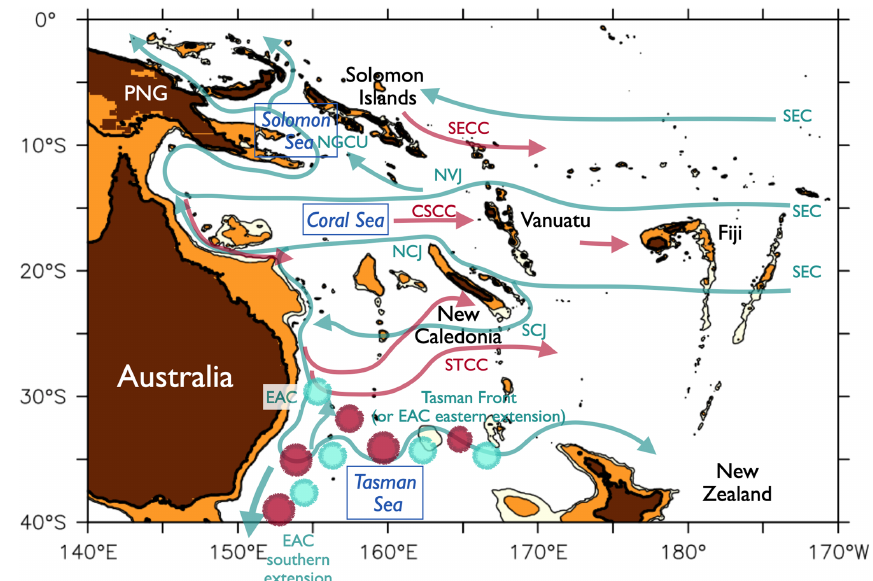
Figure 1. Reference map of the southwestern Pacific, with the names of the main islands and countries, and a schematic of the subsurface circulation (top 1000m, green arrows) and surface circulation, shown when different from the subsurface (red arrows). Brown and orange shading shows bathymetry at depths of 500 and 1000m. PNG: Papua New Guinea. Indicated are the branches of the SEC (South Equatorial Current), the NVJ (North Vanuatu Jet), the NCJ and SCJ (North and South Caledonian Jet), the STCC (Subtropical Countercurrent), EAC (East Australian Current), NGCU (New Guinea Coastal Undercurrent), and the SECC (South Equatorial Countercurrent). The red and green circles are schematics for the eddy field. The map is based on previous literature, in particular Ganachaud et al. (2004) and Oke et al.